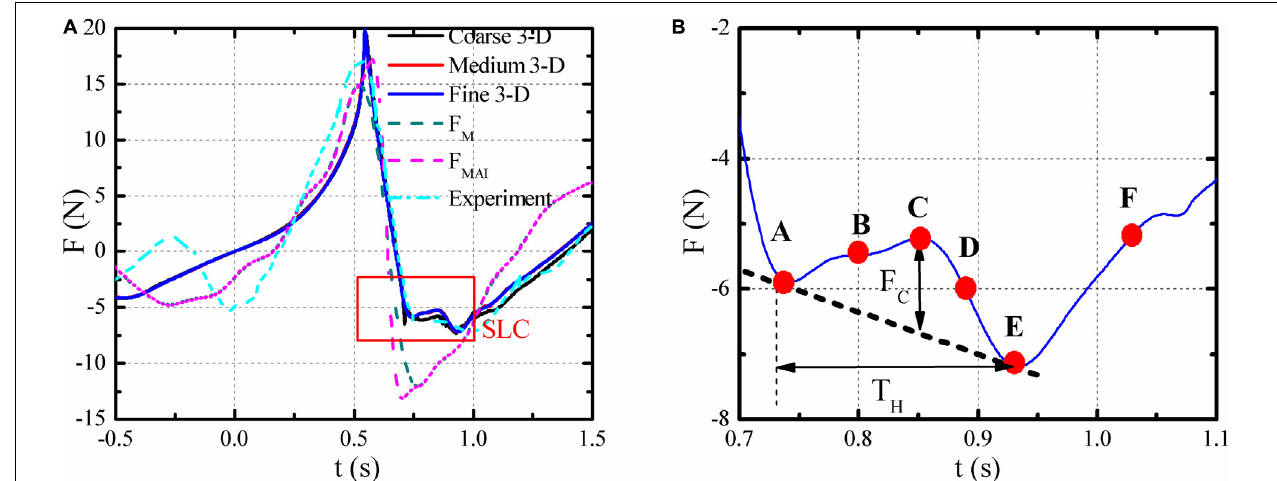
FIGURE 7 | Inline forces acting on the cylinder. (A) Inline forces, (B) numerical results of the